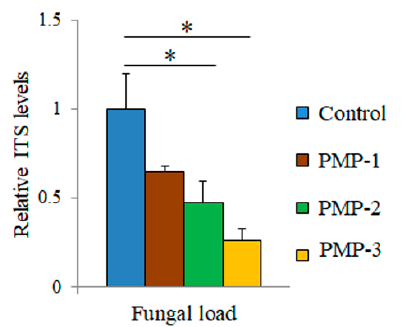
Figure 10. Quantification of fungal load in the leaves of tomato plants 5 days post-spraying with microparticles prepared from porous microparticle MgO. ITS levels in control samples were arbitrarily set to 1. Error bars denote ± STDEV (* p -value < 0.05).